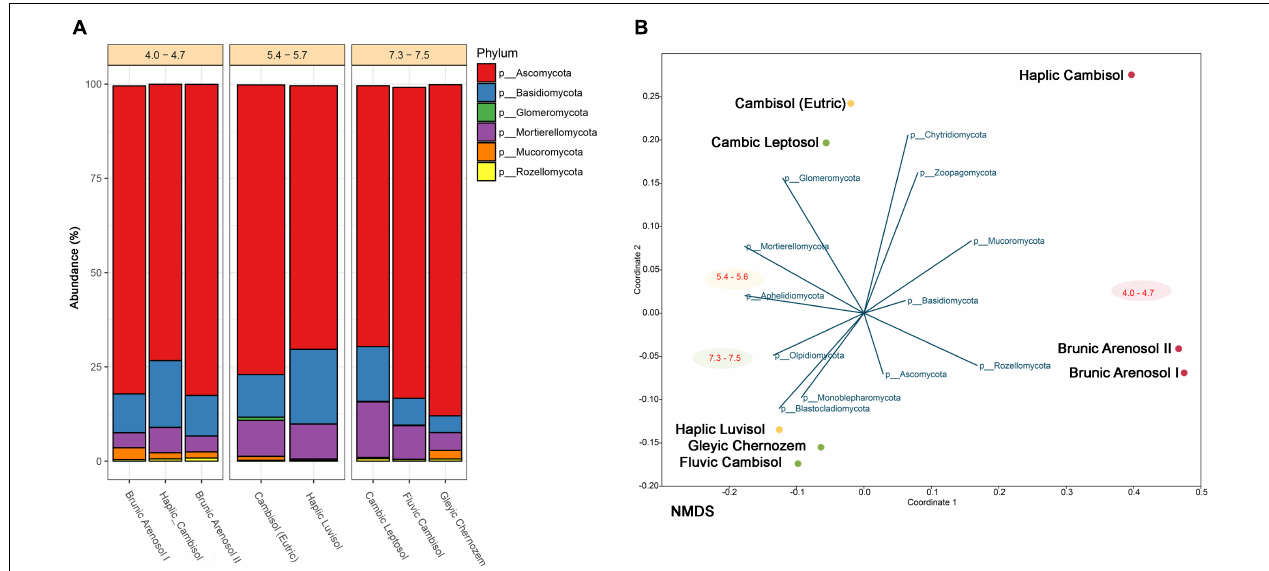
FIGURE 2 | (A) Classification of fungal community at the phylum level corresponding to each soil in terms of relative abundance. Soils sharing similar pH are grouped. Unclassified reads and phyla below 1% are substracted. (B) NMDS (Non-metric Multidimensional Scaling) analysis of soil samples correlated to each fungal phyla abundance.